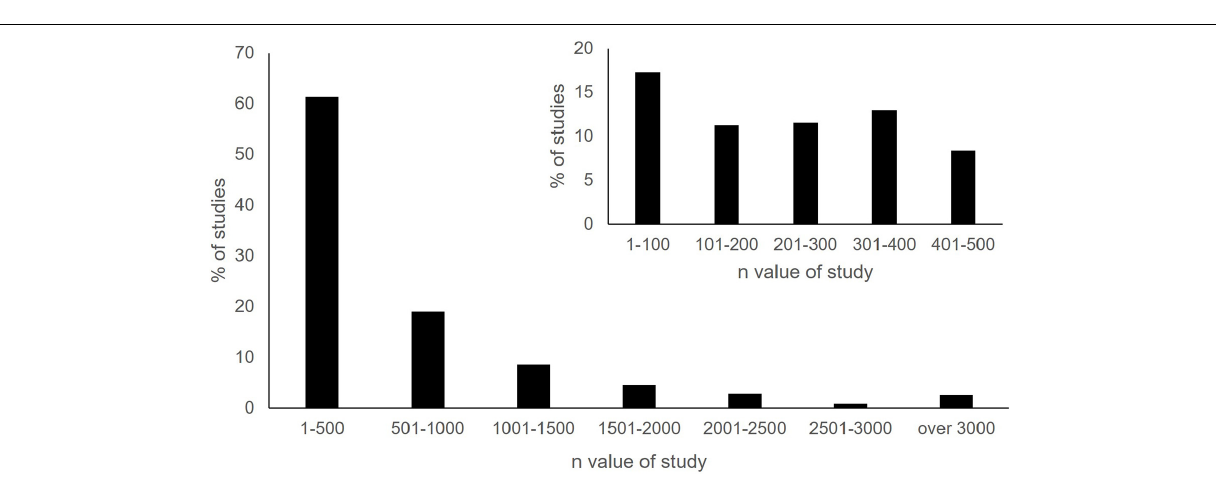
FIGURE 4 | Percentage of ocean perceptions studies measuring dimension of public perceptions research; studies could be in one or more categories ( n = 349).